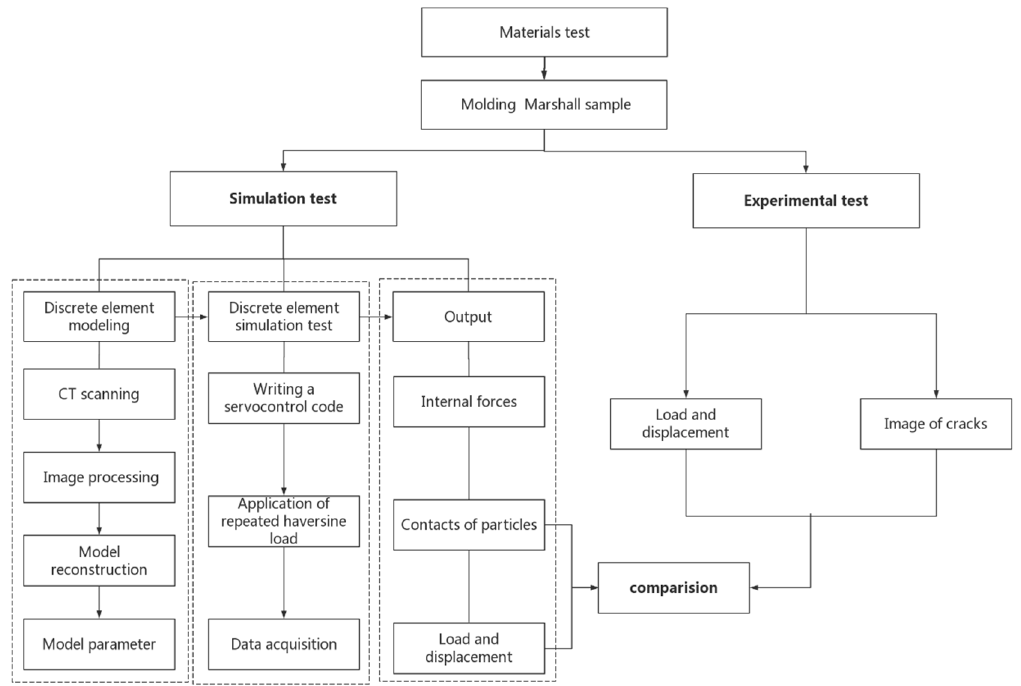
Figure 2. Flowchart of steps of the test.